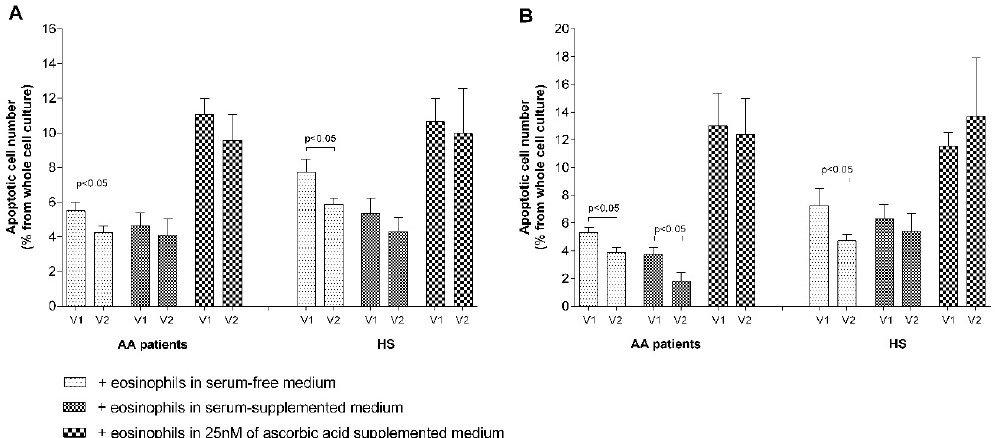
Figure 11. The e ff ect of a bronchial allergen challenge on pulmonary structural cell apoptosis. ( A ) The e ff ect of a bronchial allergen challenge on eosinophil-induced ASM cell apoptosis. ( B ) The e ff ect of a bronchial allergen challenge on eosinophil-induced pulmonary fibroblast apoptosis. Results from independent experiments of AA— n = 11, HS— n = 11; V1—Visit 1 (before the bronchial allergen challenge); V2—Visit 2 (24 h after the bronchial allergen challenge). Added blood serum—2% of v / v ; ascorbic acid concentration—25 nM. Statistical